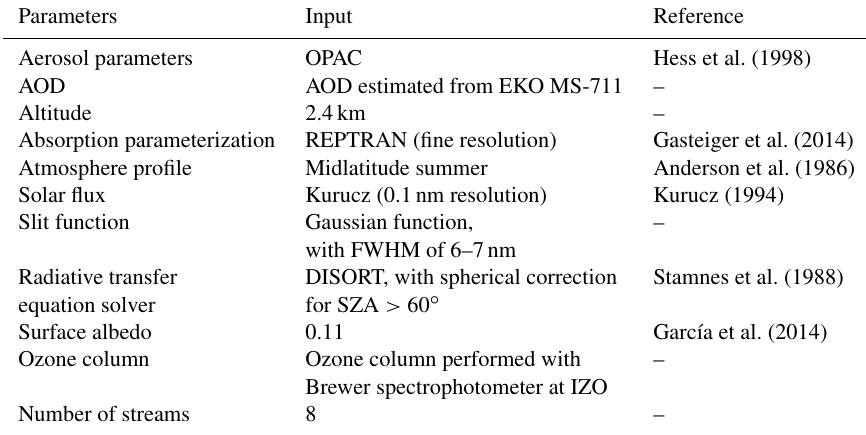
Table 3. The inputs to the libRadtran model used in this work. Parameters